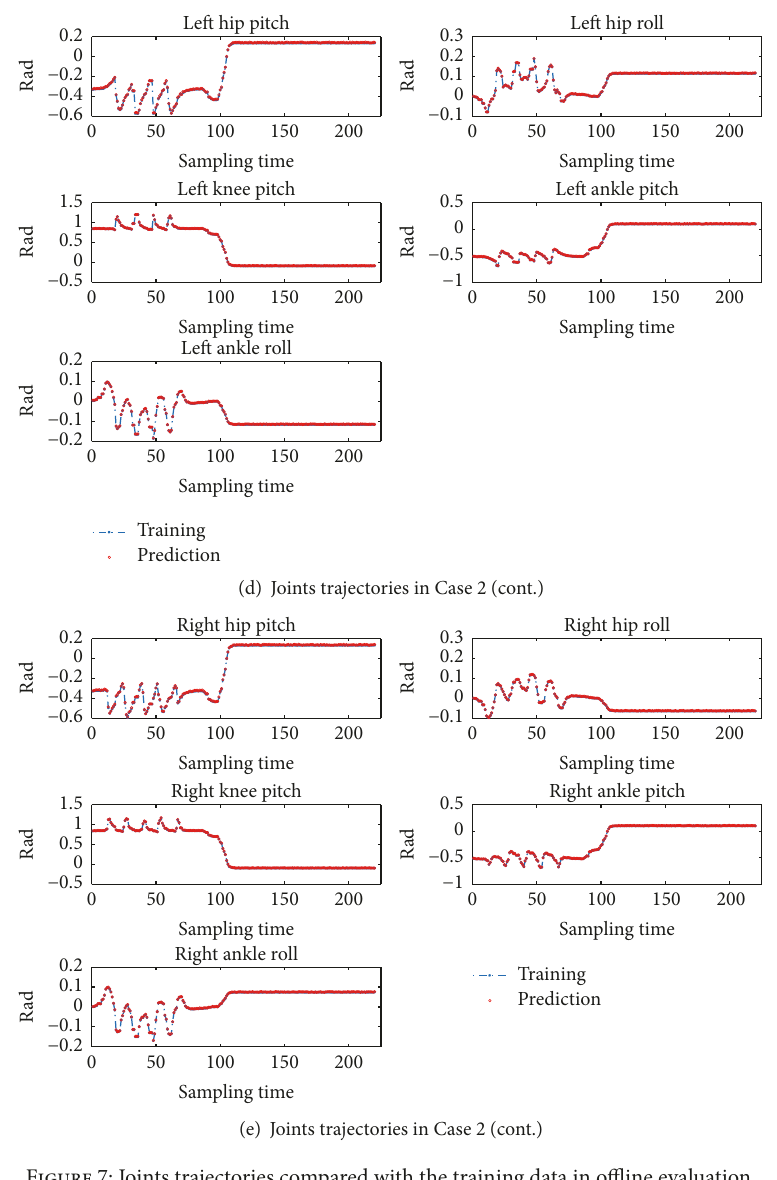
Figure 7: Joints trajectories compared with the training data in offline